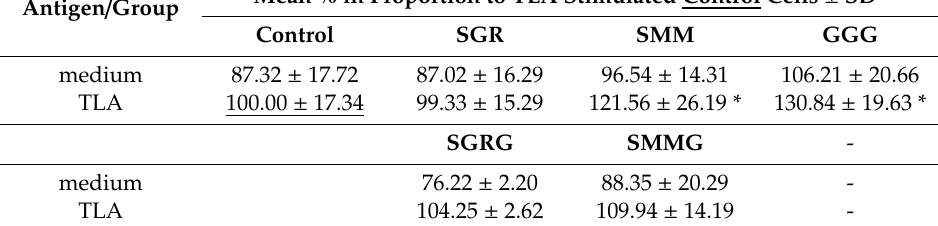
Table 3. Proliferative response of spleen cells of vaccinated and control mice stimulated with TLA in